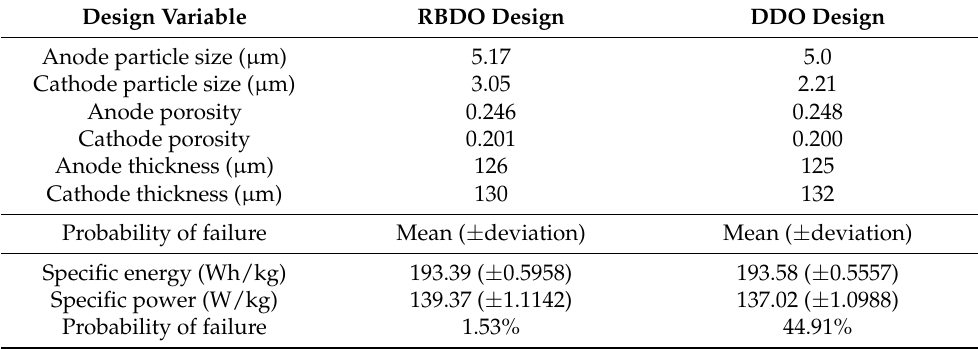
Table 5. Comparison of design variables and probability of failure between the reliability-based design optimization (RBDO) and deterministic design optimization (DDO).